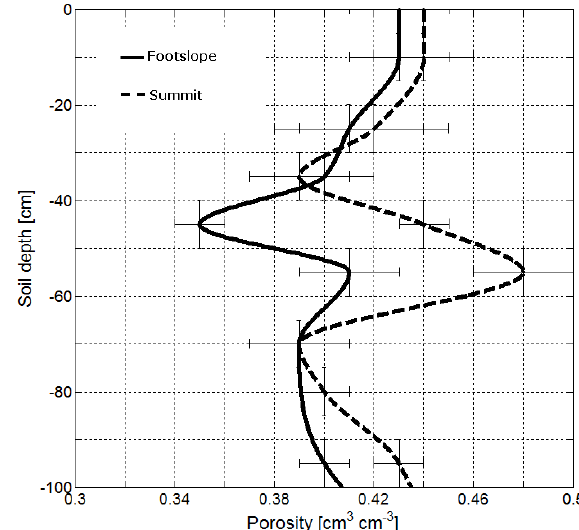
Figure 2. Soil porosity profiles at the footslope (plain line) and at the summit (dashed line) positions. Error bars indicate standard de- viation ( n ≥ 3). Curves are linearly interpolated